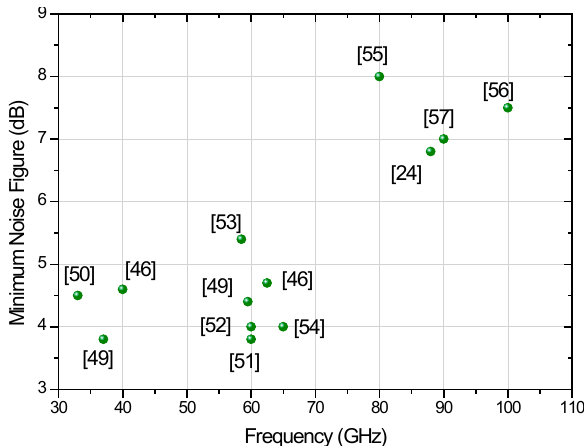
Figure 1. Measured minimum noise figure of the recent published millimeter-wave (MMW) complementary metal oxide semiconductor (CMOS) low noise amplifiers (LNAs). Data taken from [24,46,49–57].